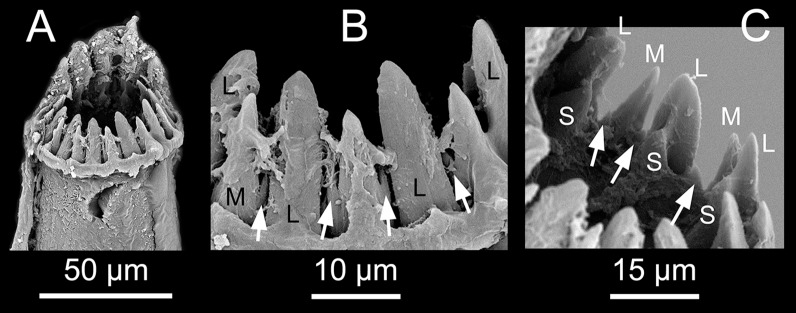
Proceraea exoryxae sp. nov. SEM micrographs of trepan structure.(A) Whole view of the trepan (teeth on the back partly covered by tissue) [MNCN 16.01/17720]. (B) Large and medium, tricuspid teeth in external view. (C) Large, medium, tricuspid and small teeth in internal view. L, Large teeth; M, Medium, tricuspid teeth; S, small teeth; white arrows pointing on the lateral cusps.